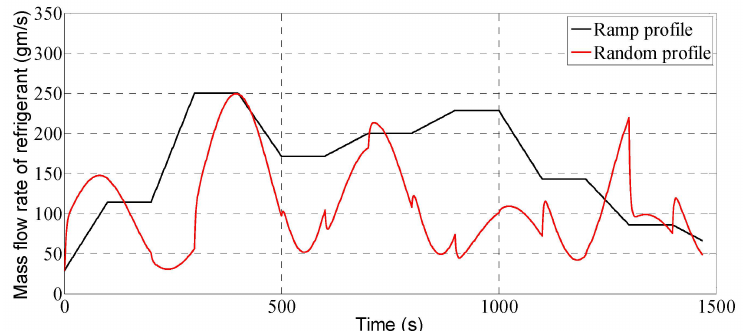
Figure 8. The mass flow rate of refrigerant profiles.